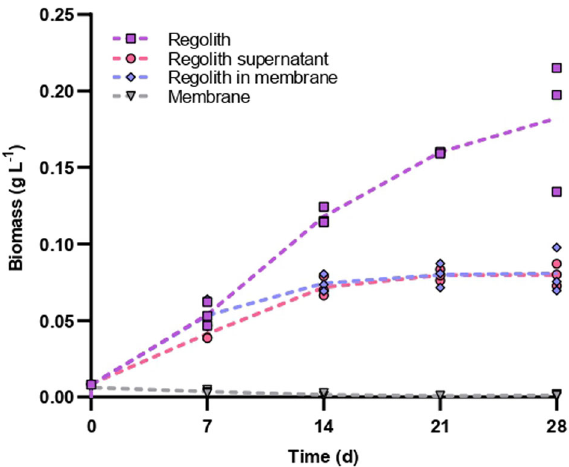
Fig. 5 Growth of Anabaena sp. PCC 7938 when utilizing MGS-1, with or without direct cell-grain contact. Cyanobacteria were grown in ddH 2 O containing 200 kg m − 3 of MGS-1 (regolith; squares), ddH 2 O in which MGS-1 had been incubated for 28 days and from which it had been removed (regolith supernatant; circles), ddH 2 O with 200 kg m − 3 of MGS-1 contained in a cellulose hydrate dialysis membrane (regolith in membrane; diamonds), or ddH 2 O with an empty dialysis membrane (membrane; triangles). Cultures were shaken but in such a way that MGS-1 would remain at the bottom of the fl asks, thereby minimizing cell